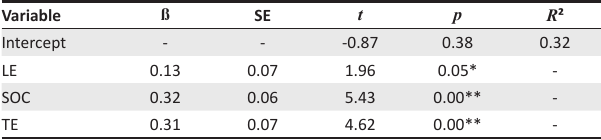
TABLE 3: Regression analysis with work engagement as dependent variable.